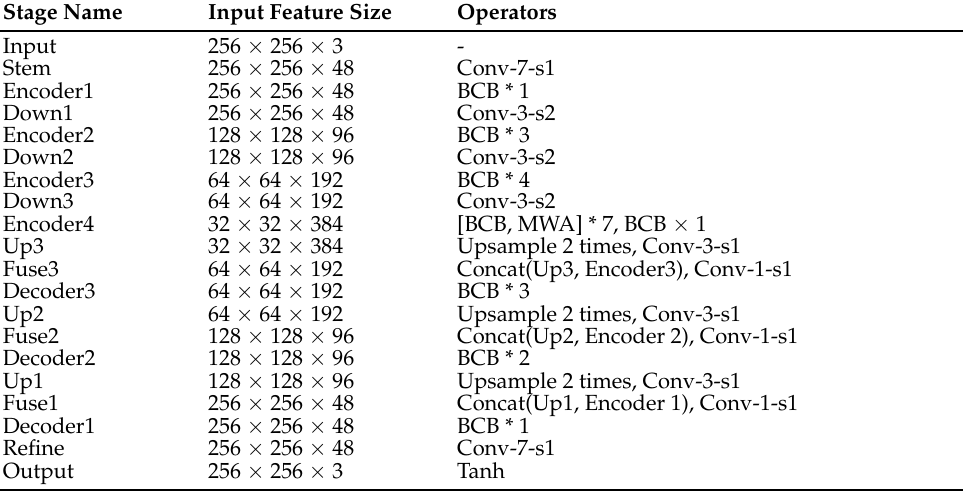
Table A1. Details of the proposed inpainting network. “Conv-k-sy” denotes convolution with kernel size k and stride y. “BCB”, "MWA", and "Tanh" represent the BC block, the MWA module, and the tanh activation function, respectively. " × " denotes multiplication. "* N" denotes stacking N